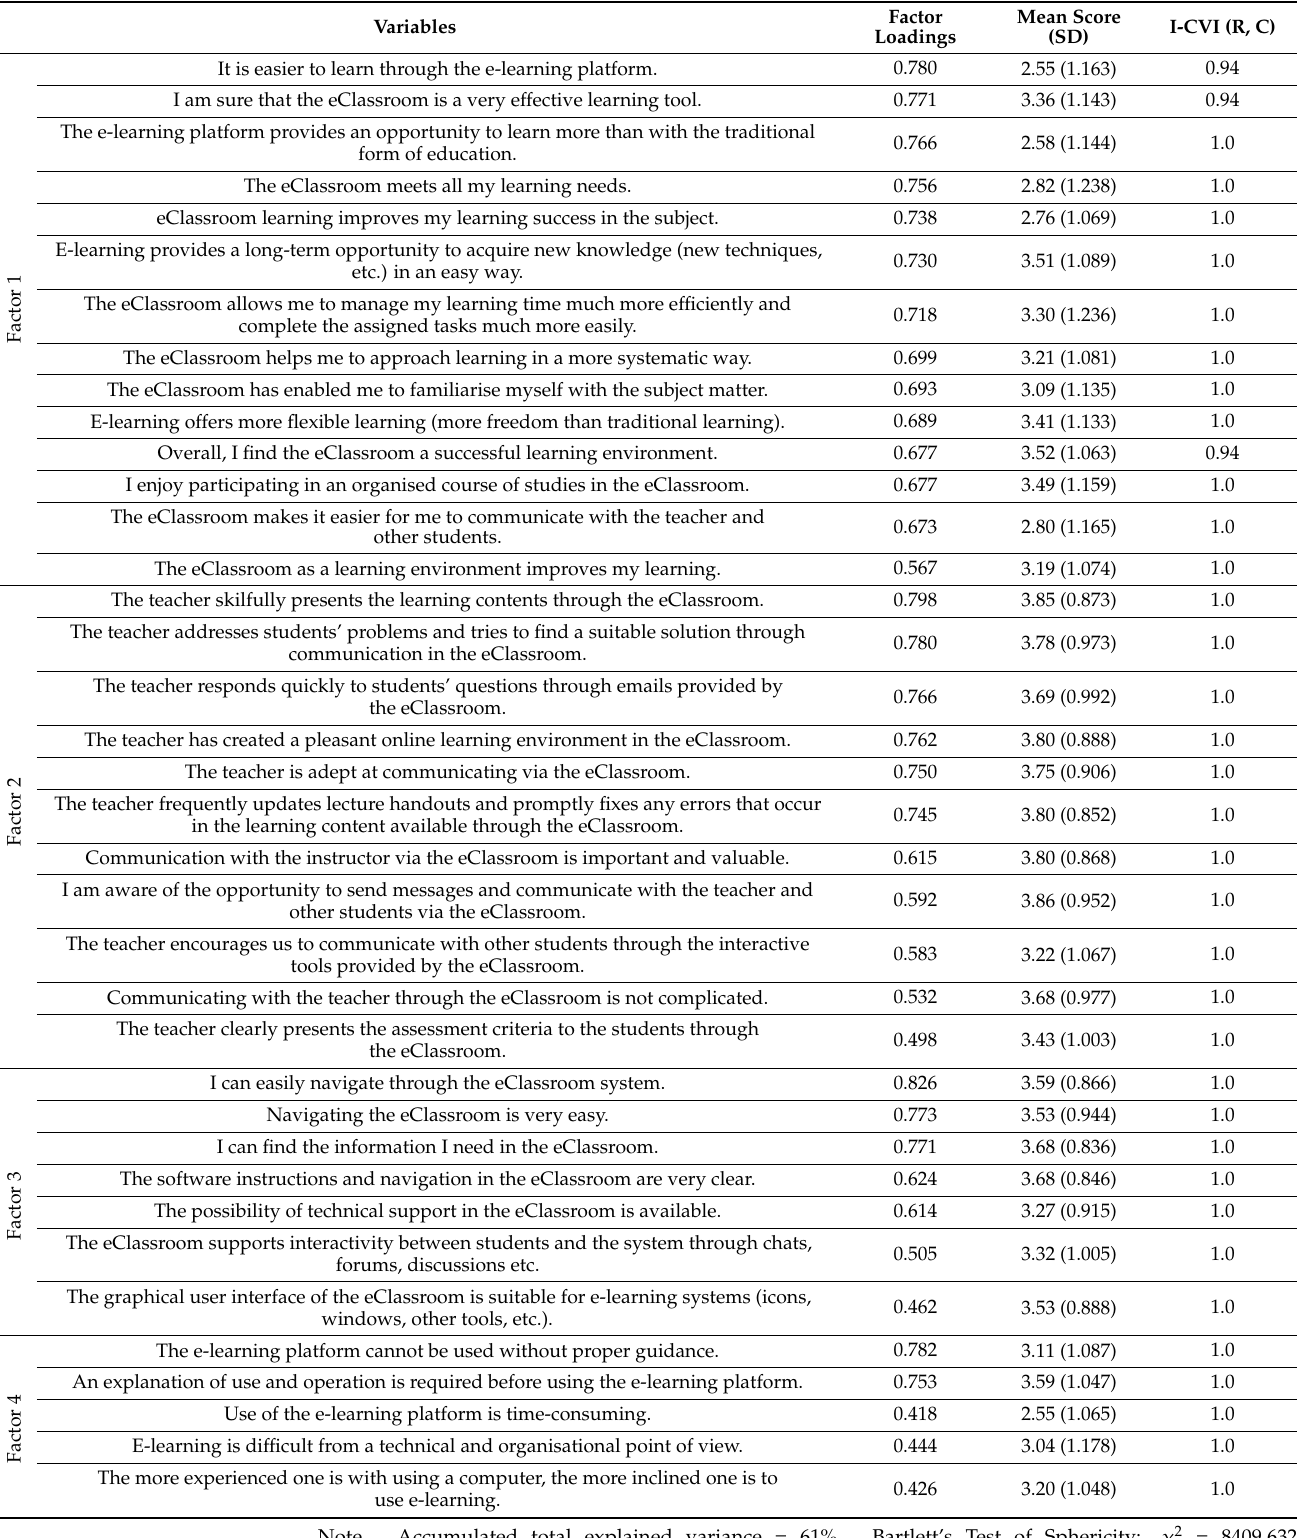
Table 2. Confirmatory factor analysis results of the 4-factor solution with factor loadings ( n =